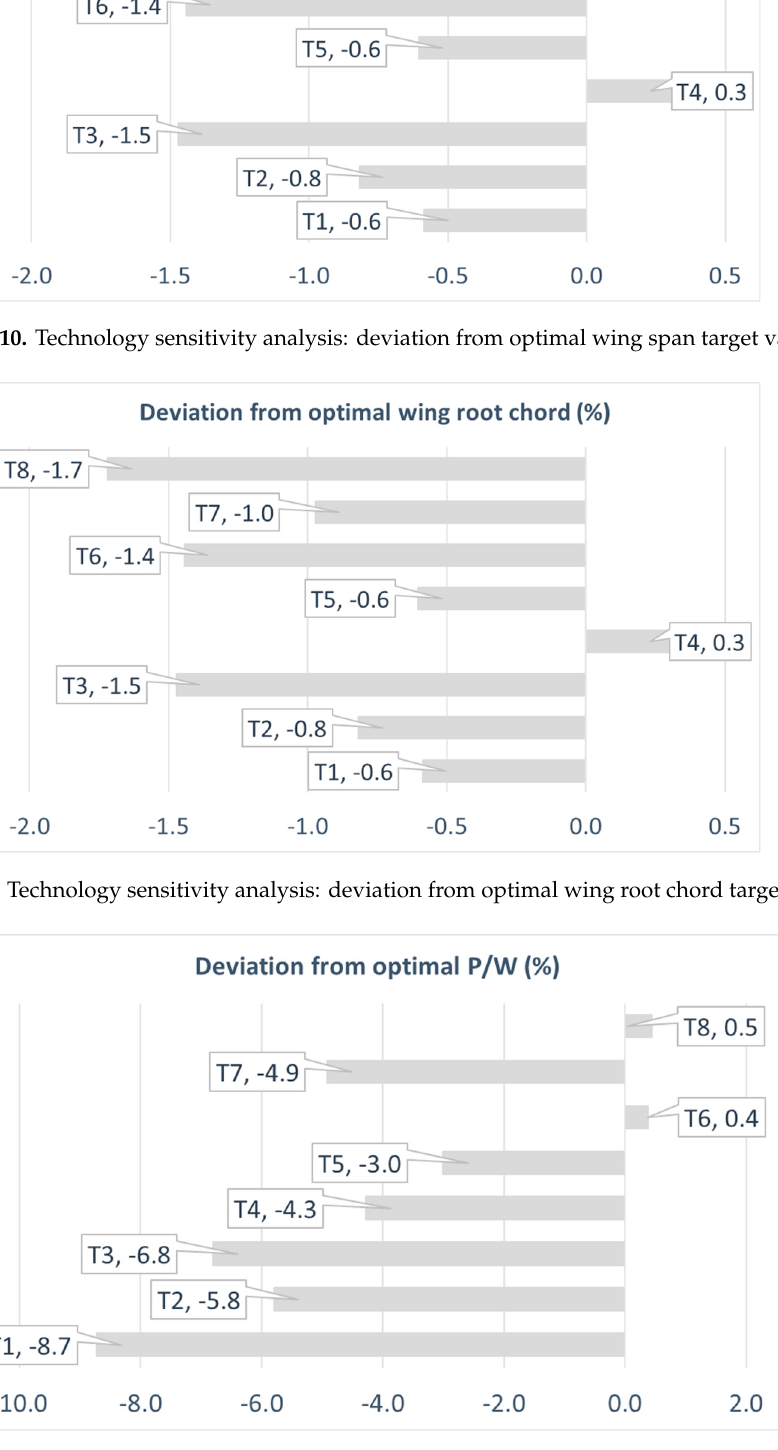
Figure 12. Technology sensitivity analysis: deviation from optimal power-to-weight target value.